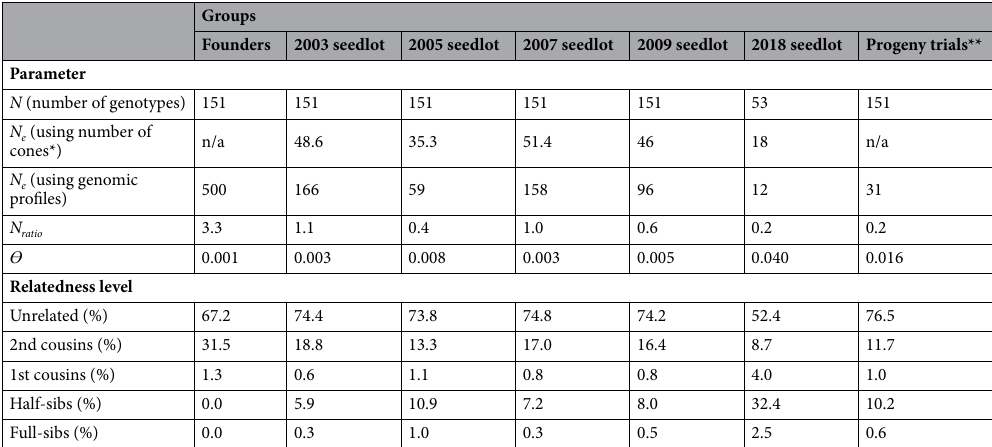
Table 1. Summary table with population size and coancestry parameters across groups (founders, seed orchard seedlots by year of collection and progeny trial trees) in the G1 white spruce orchard, using tree genomic profiles with a set of 2000 SNPs. N is the number of genotypes present in the clonal seed orchard (actual population size). Effective population size ( N e ) was calculated by two methods: using numbers of cones per genotype and SNP profiling (see Methods). N ratio is N e (genomic profiles)/N . Coancestry coefficient ( Ɵ ) was disaggregated to calculate relatedness levels (%) for each group. *These values were calculated following FGRMS (2016). **Relatedness levels for progeny trials were calculated among